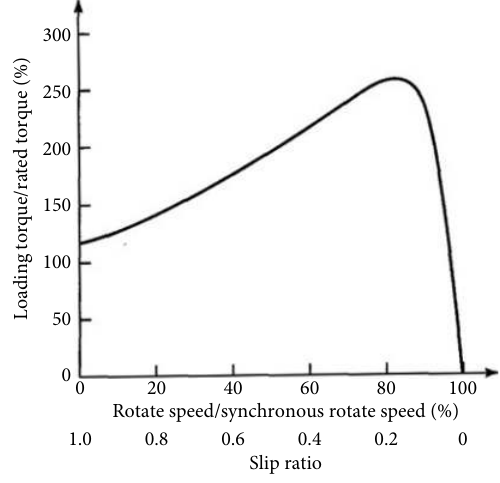
Fig. 8 Operation characteristics of IM.